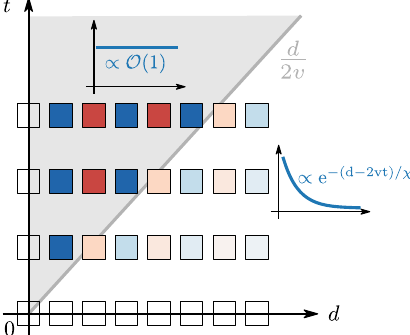
FIG. 10. Quasiparticle velocity along the ramp used in Fig. 4 obtained by linear spin-wave theory ( a denotes the lattice spacing). The maximal velocity is reached when the ramp crosses the phase boundary at t ≈ 0 . 5 μ